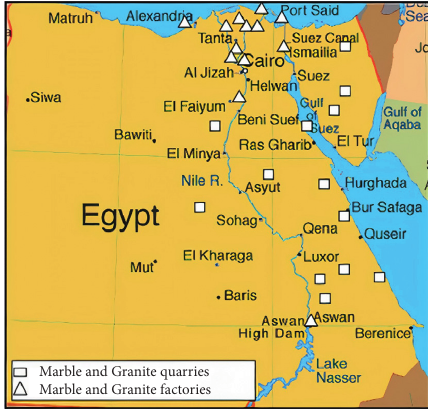
Figure 1: Location of marble, granite quarries, and factories in Egypt